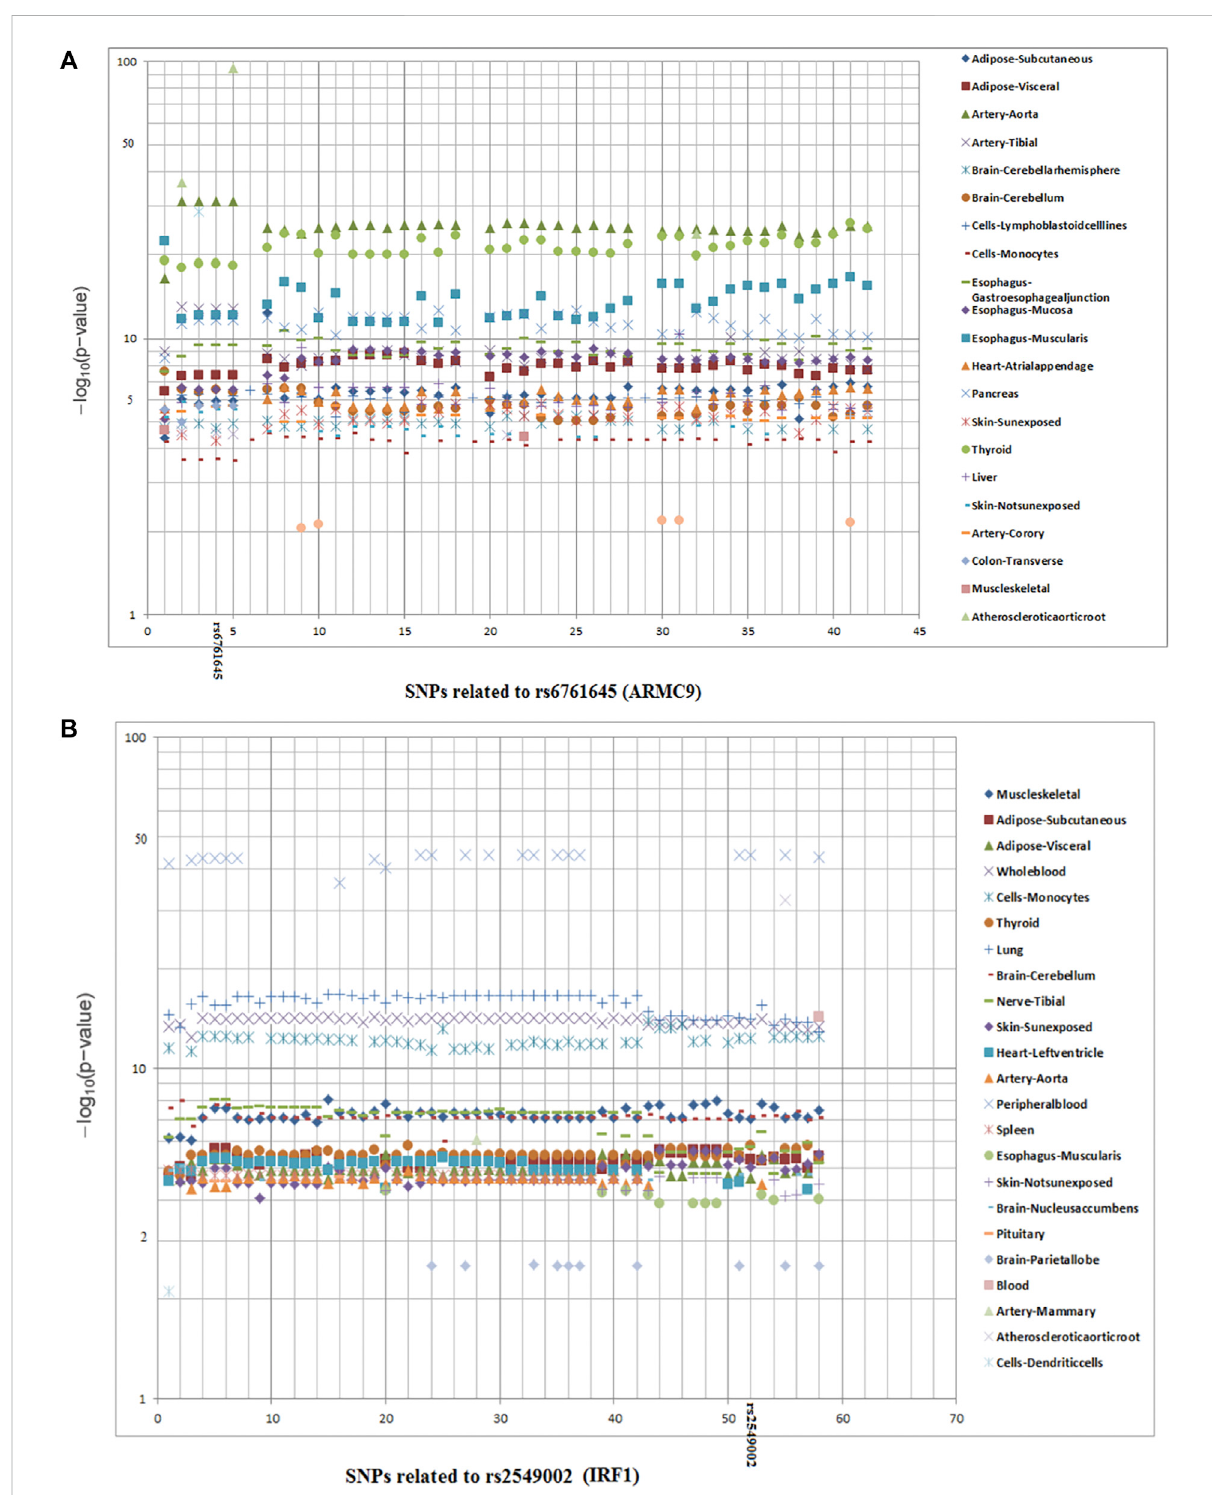
FIGURE 5 (A,B) . eQTL plots for the related SNPs ( r 2 > 0.8 with top SNPs) in two notable